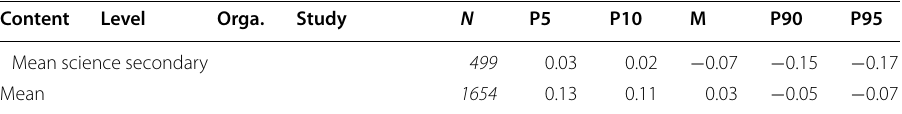
Table 2 focuses on gender variability. Four categories are presented: (1) the proportion of countries where the gender variance ratio was significantly greater than 1 (i.e. males’ variance is significantly greater than females’ variance); (2) the proportion of countries where the gender variance ratio is greater than 1, but not significantly; (3) the proportion of countries where the gender variance ratio is lower than 1, but not significantly; (4) the proportion of countries where the gender variance ratio is significantly lower than 1 (i.e. females’ variance is significantly greater than males’ variance). For each study, the mean of the country variance ratios and its standard error is also